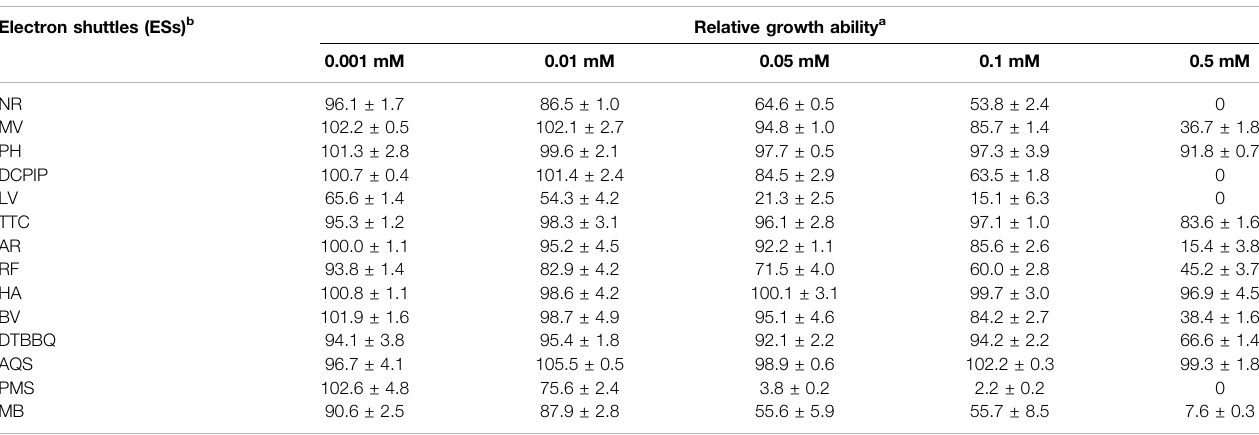
TABLE 1 | Effect of different ESs on cell growth of S. oneidensis MR-1. Electron shuttles (ESs)